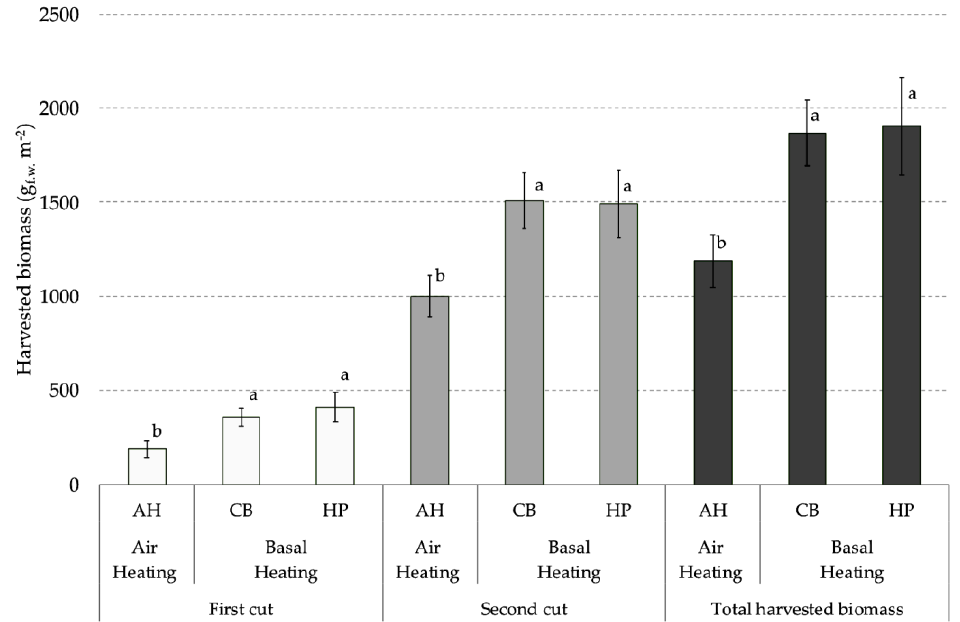
Figure 10. Average values of harvested biomass (g f.w. · m − 2 ) of the first, and second cut, and of the total harvested biomass, reported for each tested heating systems: AH (air-heater–air section); CB (condensing boiler–basal section); HP (heat pump–basal section). Data are expressed as average ± standard deviation. Means that do not share a letter are significantly different.